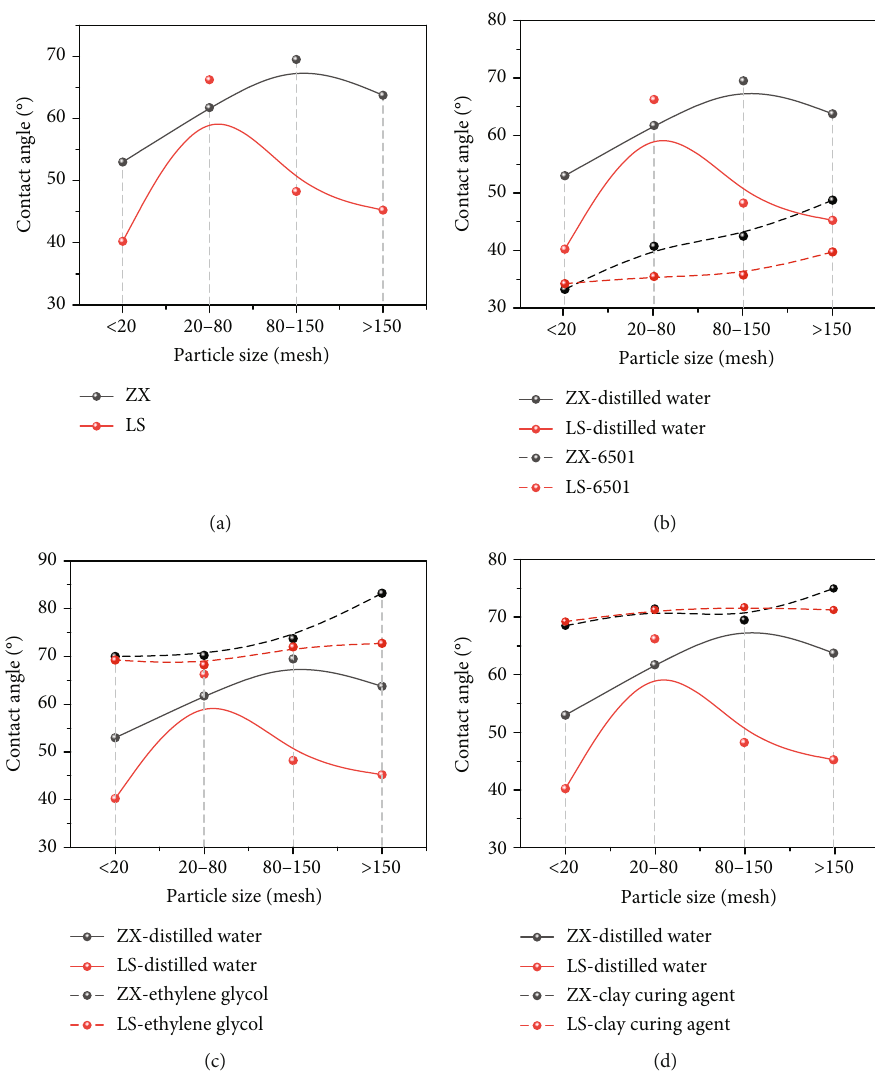
Figure 11: Contact angles of coal fi nes measured with di ff erent liquids ((a) distilled water, (b) 6501 solution, (c) glycol, and (d) clay curing